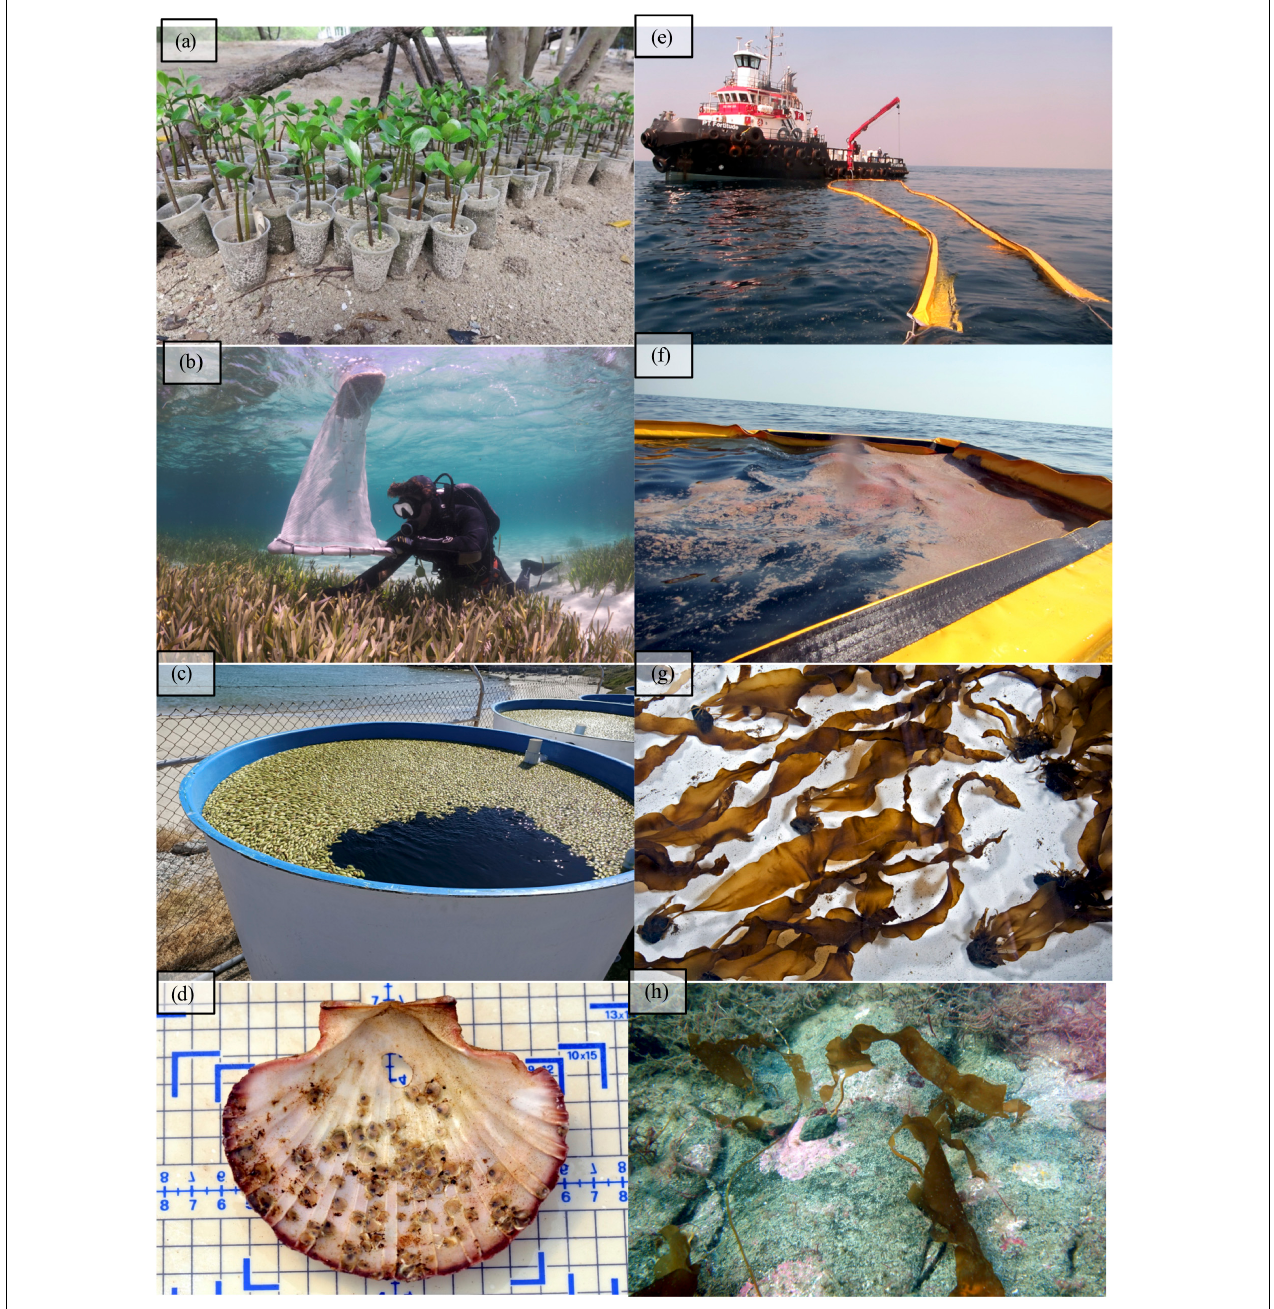
FIGURE 2 | Examples of how propagules are prepared for restoration: (a) Viviparous seedlings of Rhizophora grown in plastic pots prior to planting; (b) collection and (c) preparation in tanks of Posidonia australis fruit; (d) flat oyster ( Ostrea angasi ) spat attached to an empty shell for deployment; (e,f) collection of coral spawn using an oil boom; (g) young sporophytes of kelp ( Saccharina latissima ) seeded onto small rocks (“green gravel”) in the laboratory and (h) sporophytes outplanted to a rocky reef. Photo credits: (a) M. Vanderklift, (b) J. Statton, (c) K. Dawson, (d) Victorian Shellfish Hatchery, (e,f) Christopher Doropoulos, (g) S. Fredriksen/K. Filbee-Dexter, (h) S. Fredriksen. Images d and e reused under a Creative Commons CC-BY license from Doropoulos et al.